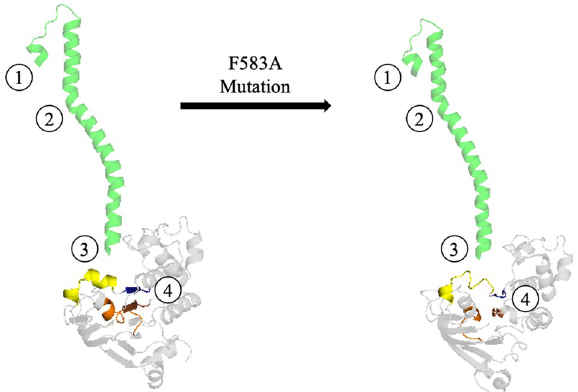
Figure 9. The allosteric pathway. F583A mutation (1) induces a change in helix 10’s angularity, making it more obtuse (2). The shifted bending propagates to the edge of helix 10, deviating its docking orientation in relation